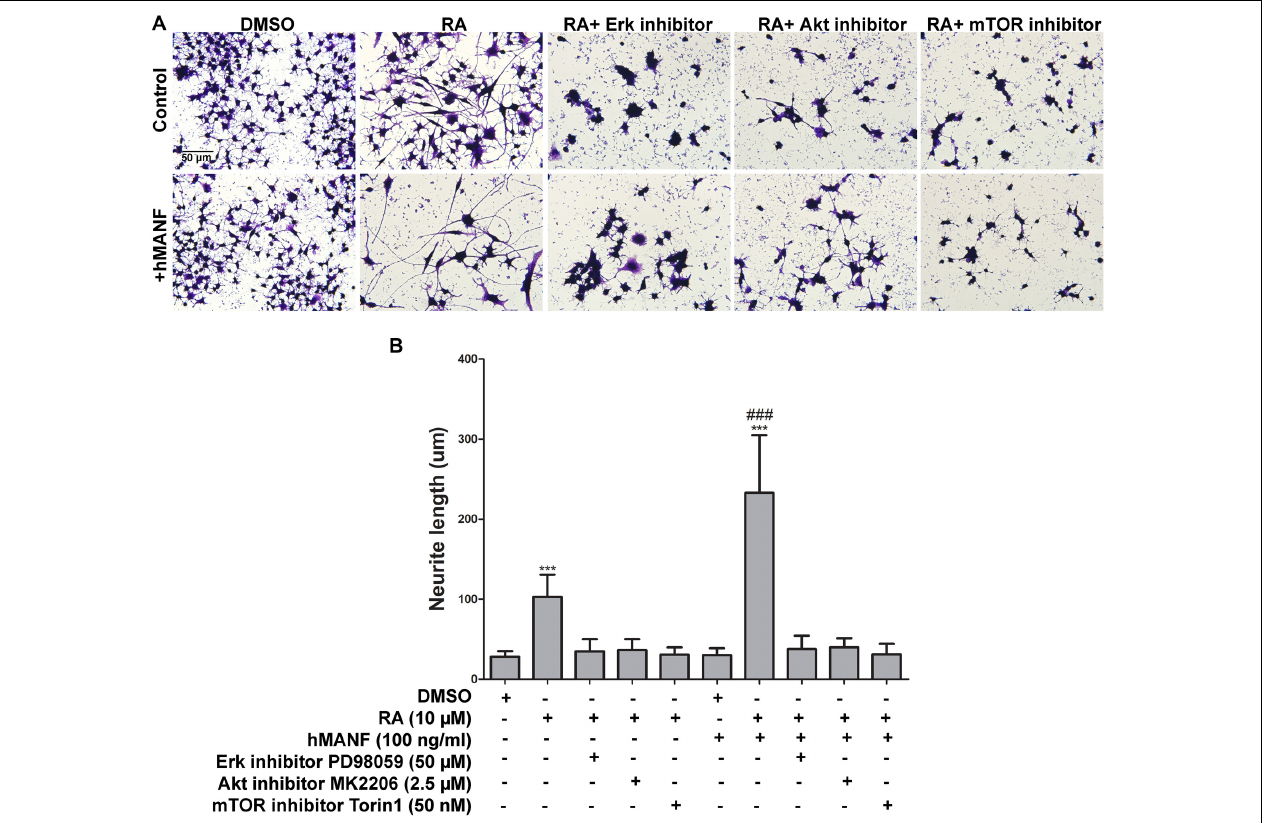
FIGURE 8 | Pharmacological inhibition of Akt, Erk, and mTOR blocks MANF-enhanced neurite outgrowth in response to RA. (A) Representative images of N2a cells treated with DMSO or RA or RA+inhibitors for 3 days with or without addition of recombinant hMANF (100 ng/ml). Cells were fixed and stained with crystal violet for visualization. (B) Average neurite length was measured, and analyzed by One-way ANOVA followed with the Tukey’s post hoc test, *** P < 0.0001 compared to DMSO treated cells, ### P < 0.0001 compared to RA treated cells. The data were expressed as the mean ± SEM of three independent